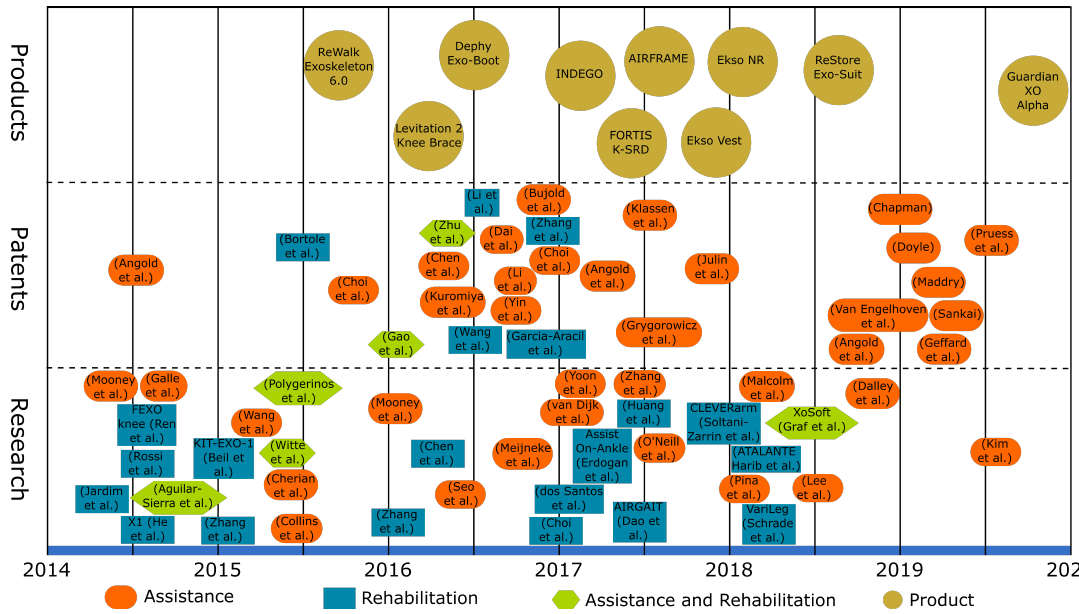
Figure 4. Timeline of the state-of-the-art of 75 different